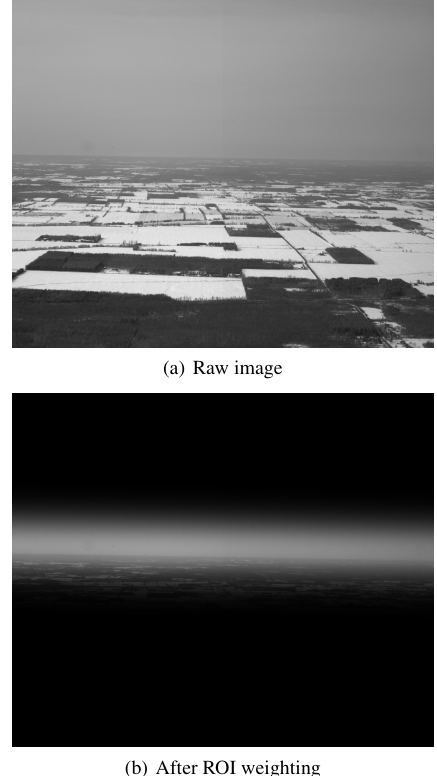
Figure 2: An image from a head-on collision couse with the March 2012 dataset with and without a ROI applied. The Bell 206 acted as the intruder. The image dimensions are 2448 columns by 2050 rows for reference. The ROI mask was generated by a Gaus- sian PDF centred at the horizon with a half-width of 150